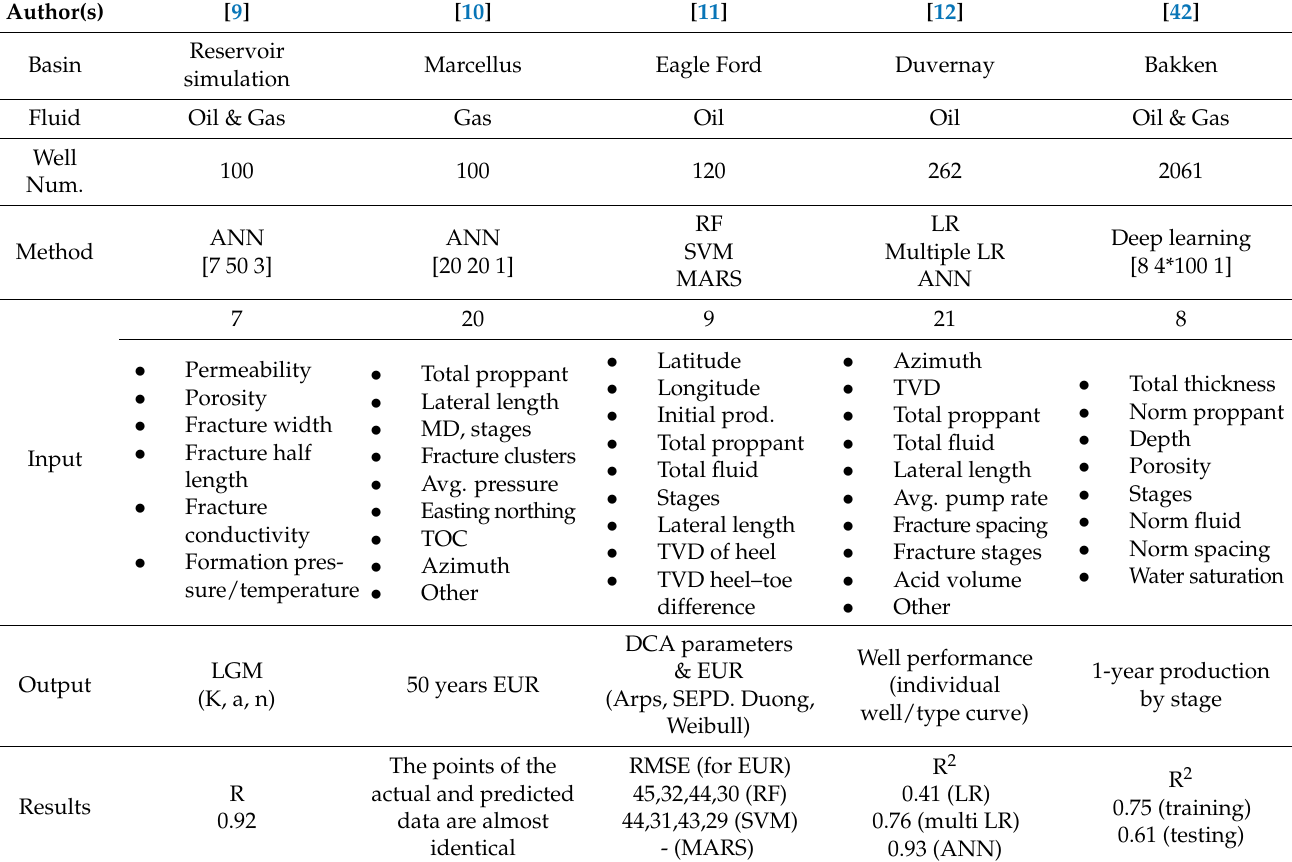
Table 1. Research on productivity prediction of existing wells in shale